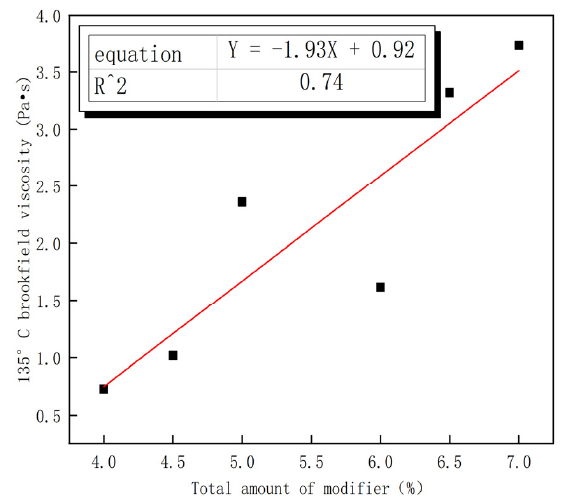
Figure 6. Relationship between total modifier content and brookfield